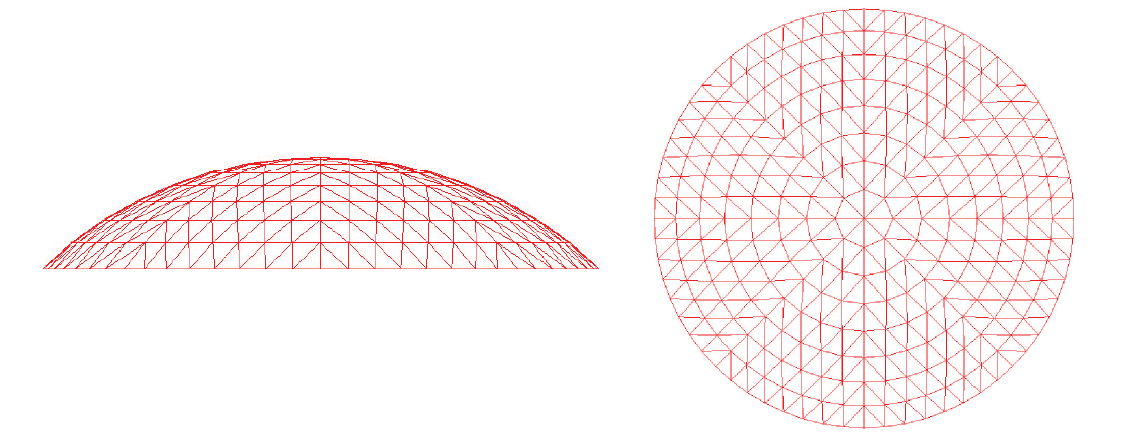
Figure 1: Simulation model of the single-layer Kiewitt-8 reticulated dome.